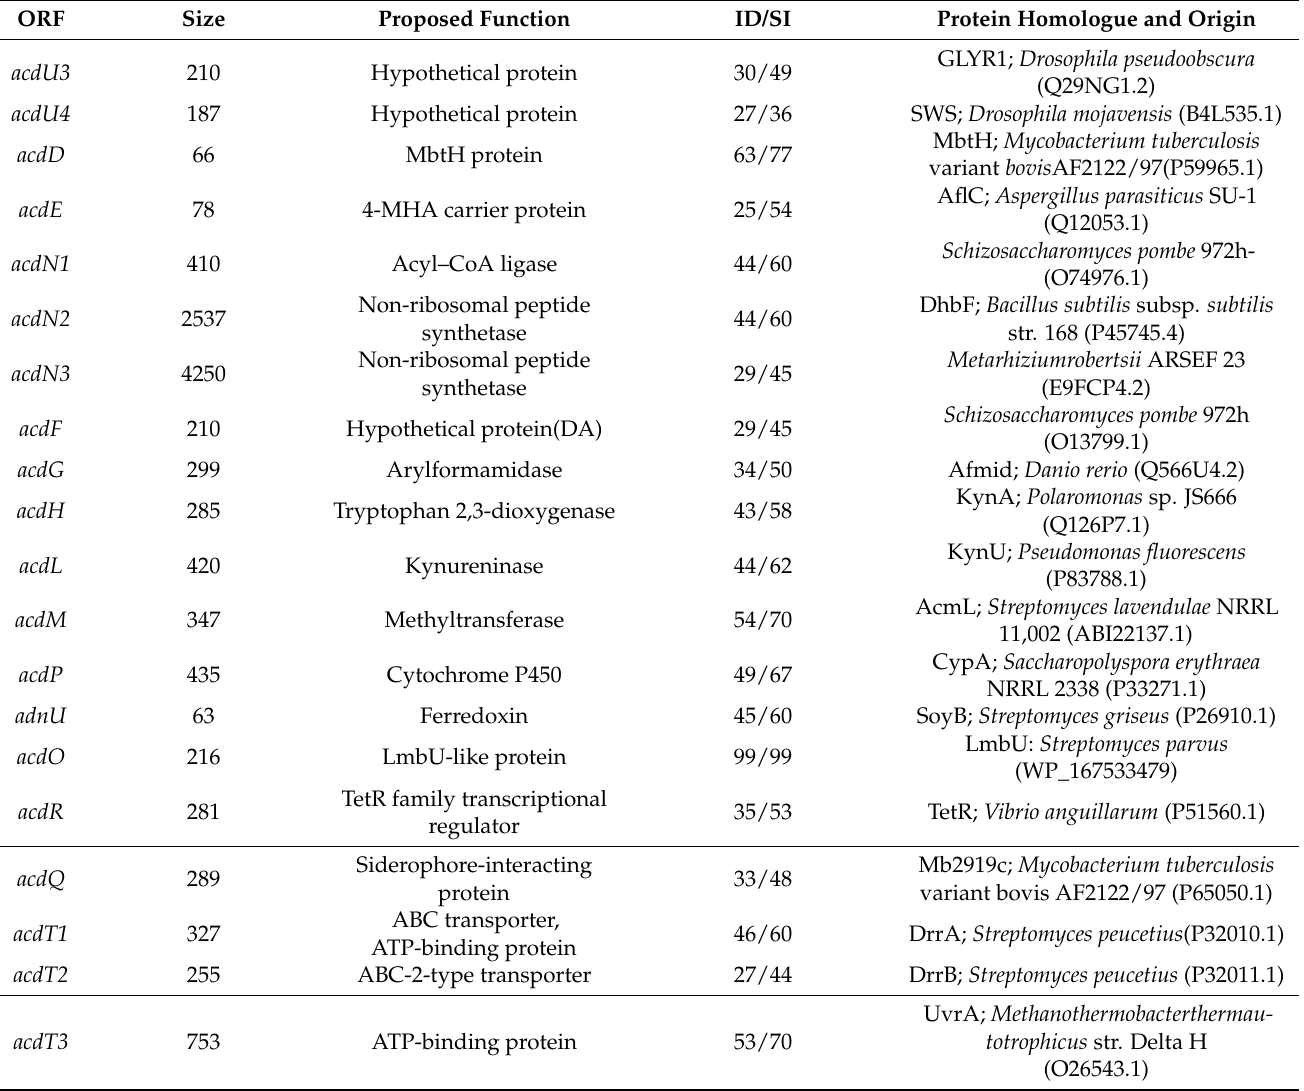
Table 3. Determined functions of ORFs in the acd BGC.